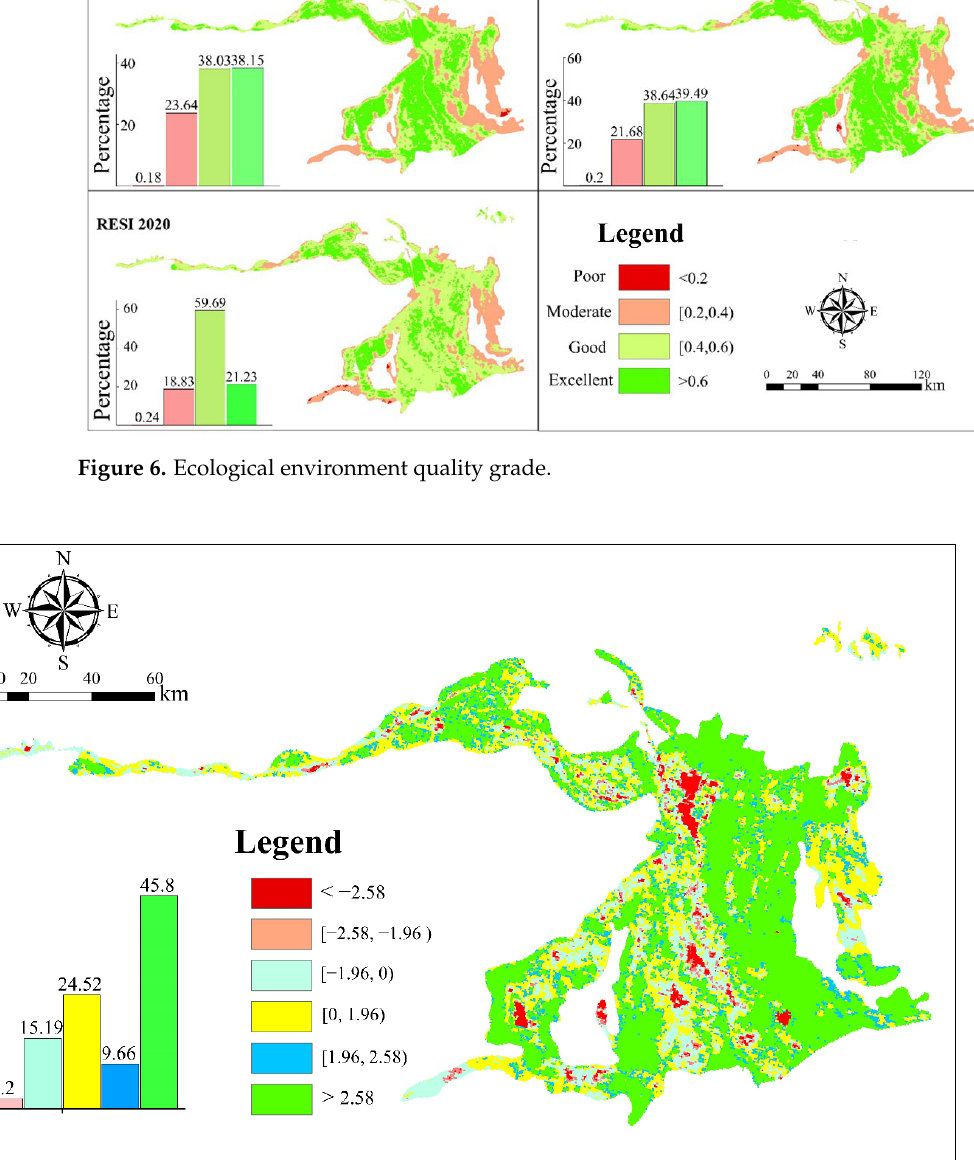
Figure 7. RSEI trend test from 2000 to 2020.